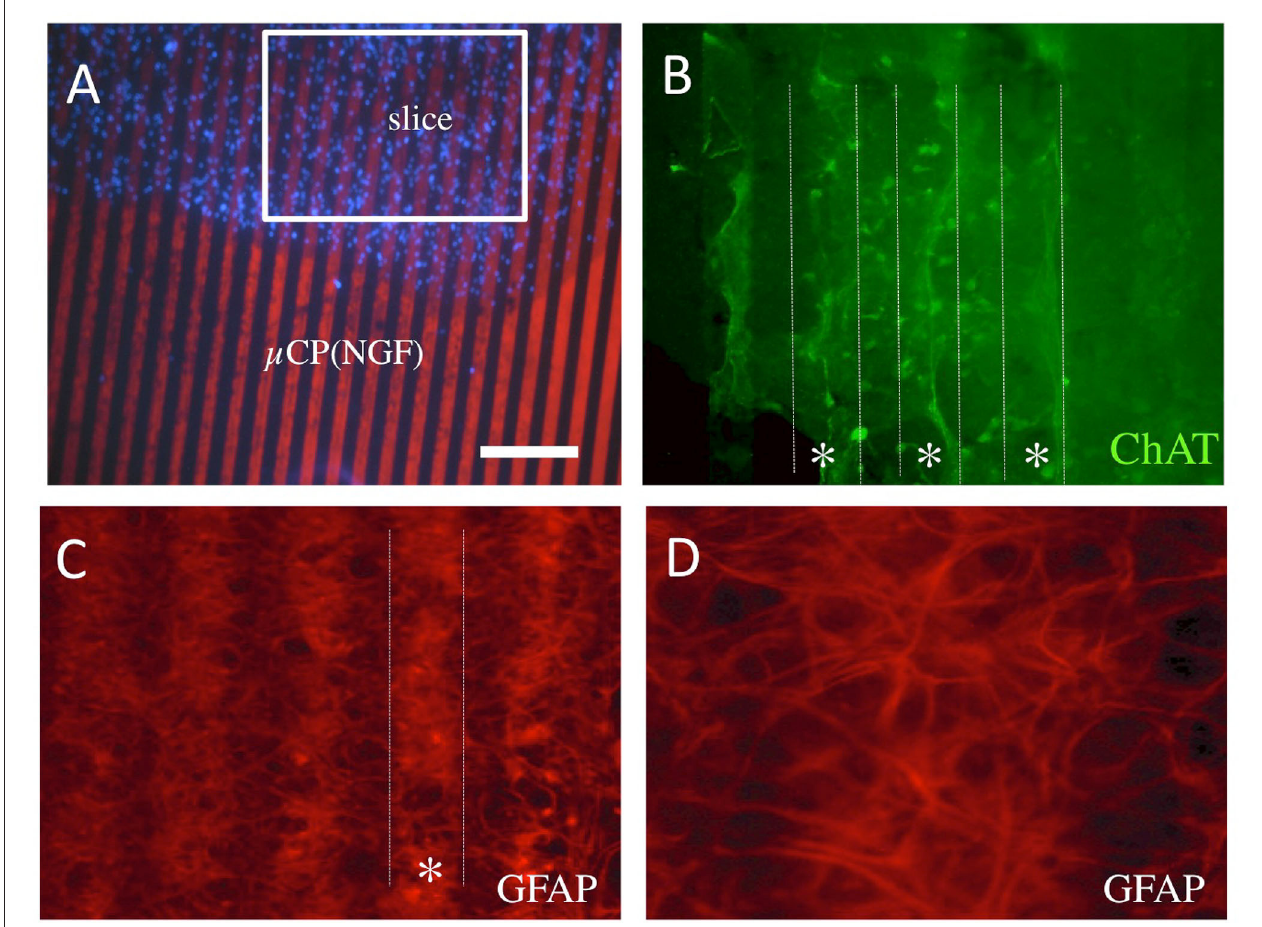
FIGURE 6 | Re-organization within the slices placed onto the NGF µ CP (A) . Note some form of the re-organization of ChAT + cholinergic neurons and fibers (B) along the µ CP [ (B) , dotted lines, star *]. The GFAP + cells and processes re-organized in the slice and grew on the NGF µ CP [ (C) , dotted white line] leaving some empty areas in-between (D) . For each representative two to four brain slices were prepared from two to five animals. Scale bar in A = 210 µ m (A) , 50 µ m (B,C) , 25 µ m (D)